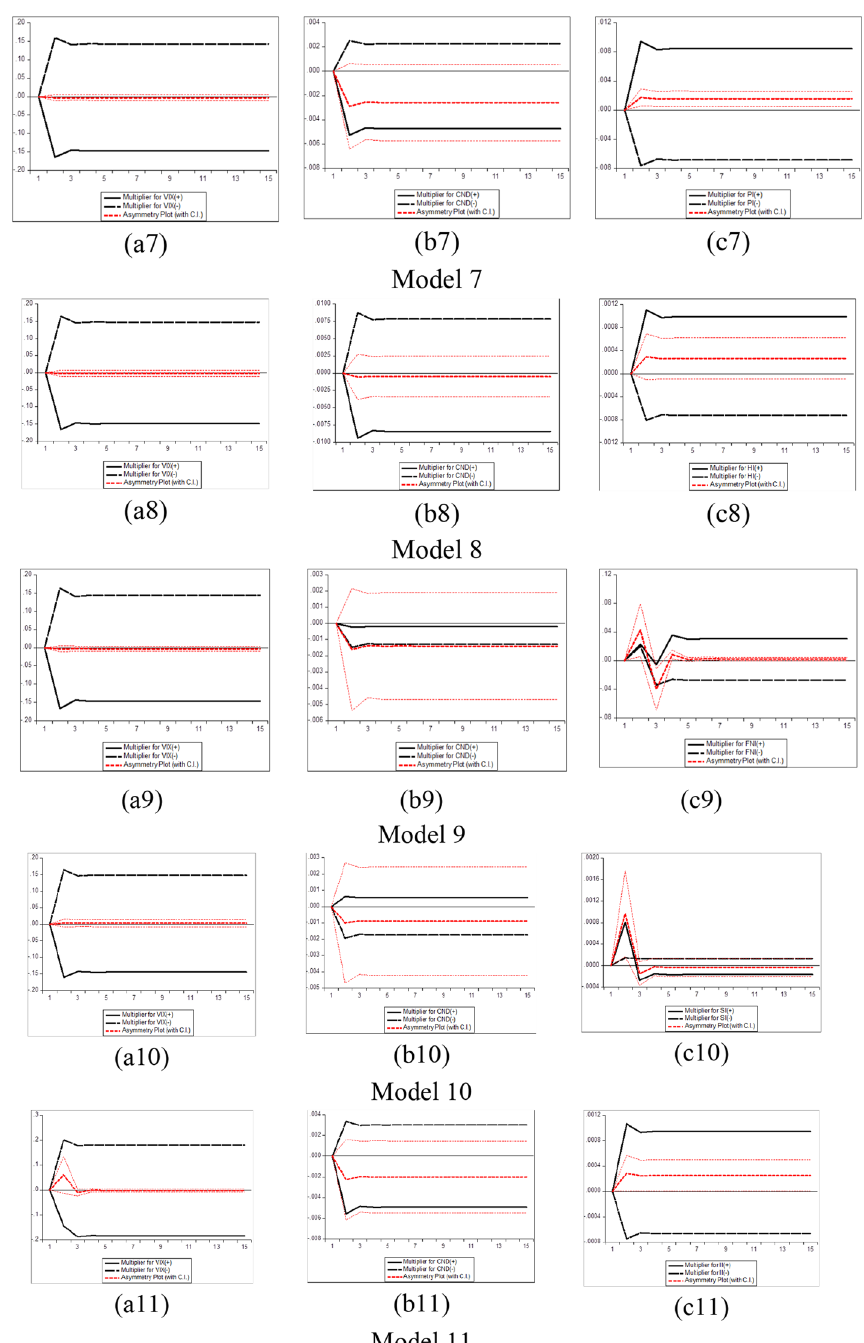
Fig. 6 Asymmetric dynamic multipliers—Models 7- 12: impact of positive and negative changes in VIX (a7–a12), daily number of new reported COVID-19 deaths worldwide (b7–b12), each RavenPack coronavirus related indices (c7–c12) on daily changes of Bitcoin price. Source Authors’ own work. Notes: The horizontal axis shows the period (days) and the vertical axis the multiplier for positive (continuous black line) and negative (dashed black line) changes in VIX, daily number of new reported COVID-19 deaths worldwide, each RavenPack coronavirus related indices and the asymmetry plot (dashed red line) with 95% bootstrap confidence interval based on 1000 replications. Variables’ description is provided in Table